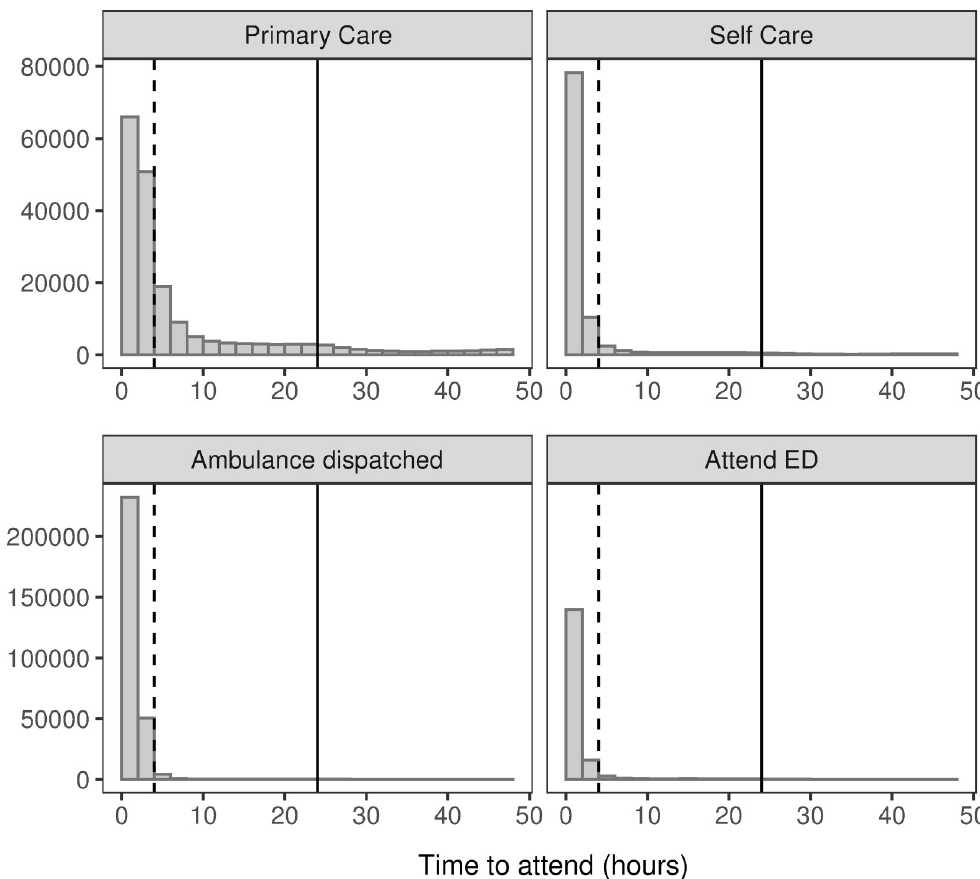
Fig 2. Distribution of hours taken to attend ED for those advised to different dispositions. Solid vertical lines denote 24 hours from the call; dashed lines denote 4 hours.